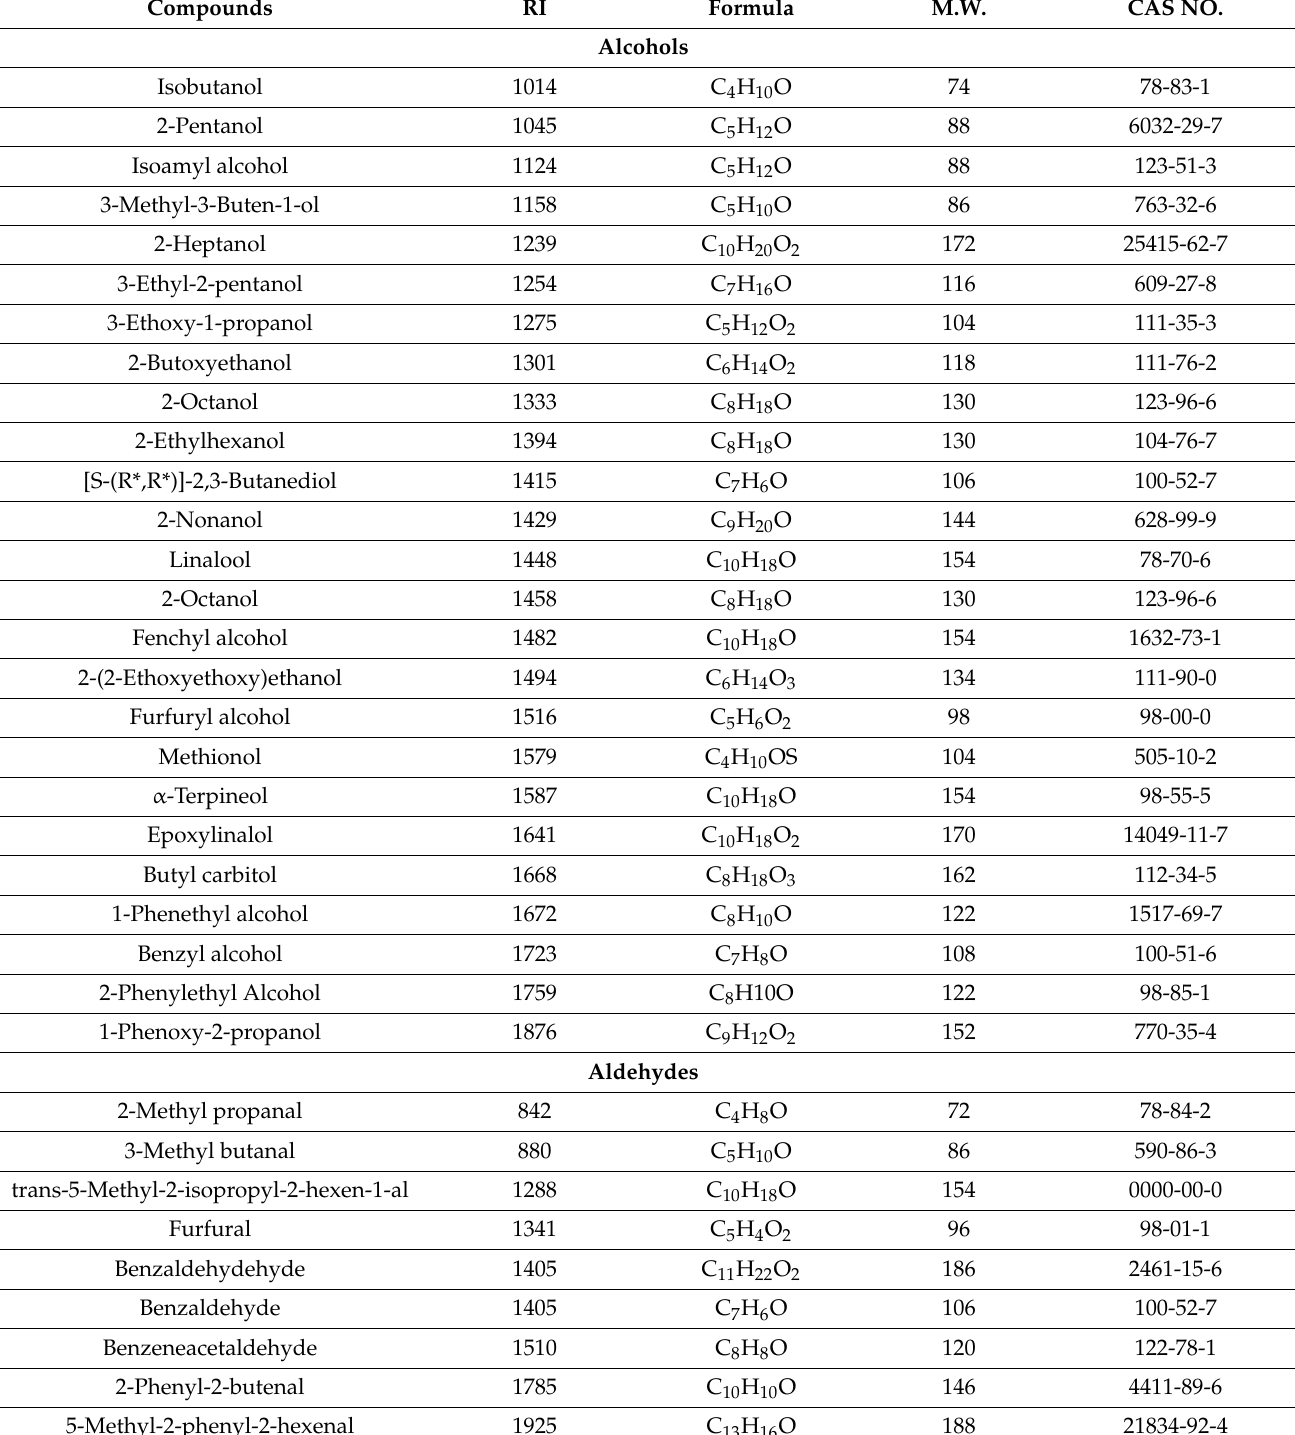
Table 9. Volatile patterns identified in differently treated polymorphic cacao beans